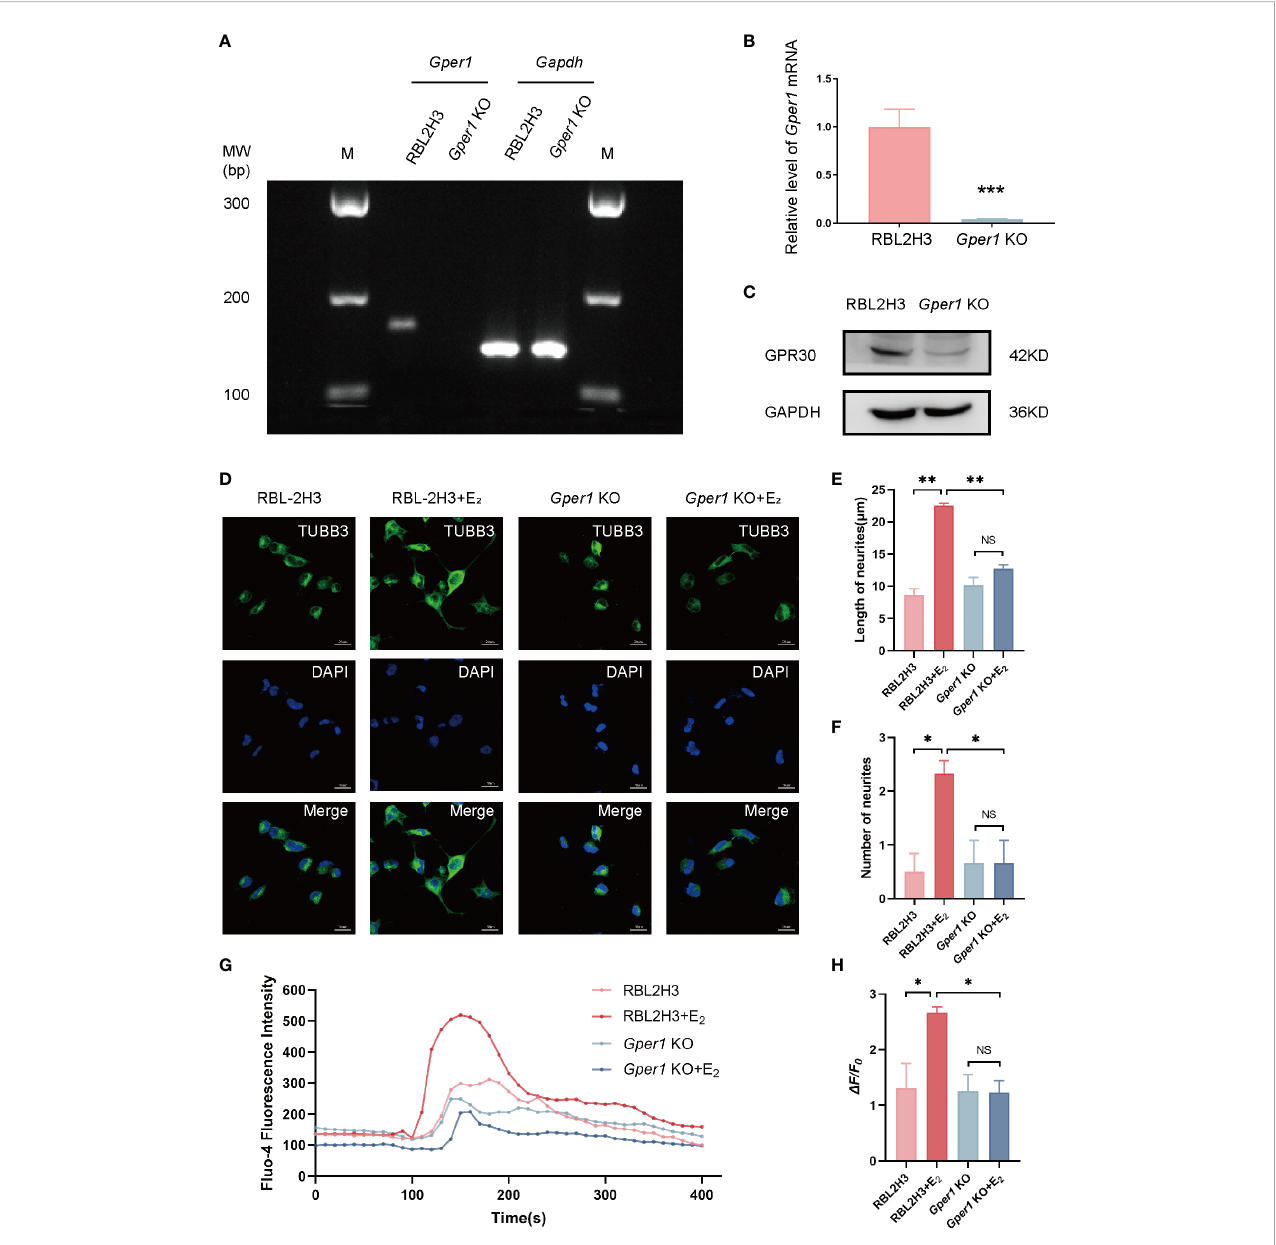
FIGURE 2 Mast cells promote the neurite growth and Ca2+in fl ux in DRGcells via GPR30. (A) Expression of Gper1 gene in mast cells, as examined by agarose gel electrophoresis (n= 3 in each group). (B) Gper1 expression in mast cells, as examinedby RT-qPCR(n= 6 in each group). (C) GPR30 protein expression in mast cells, asexamined by westernblot (n= 3 in eachgroup). (D) Representative images of cellmorphology and neurite growth in DRG cells treatedwith different supernatants frommast cells for 24h. (E) Quanti fi ed results oflength neurites indifferent groups (n= 4, 5, 3, 3). (F) Quanti fi ed results ofnumberof neurites in different groups (n= 6,9,6,6). (G) Fluo-4 fl uorescenceintensity ofF11 cells treated with different supernatants frommast cells. (H) Ca 2+ peak increase ( D F/F0 ) in F11cells treated with different supernatants from mast cells (n= 3 in eachgroup).The concentration ofE 2 is 100 nM. * P < 0.05, ** P < 0.01,NS, not signi fi